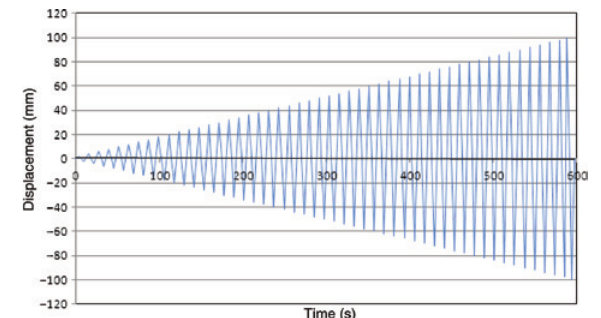
Figure 3: Application steps of glass fiber reinforced polymer sheet to the infilled reinforced concrete (RC) frames.